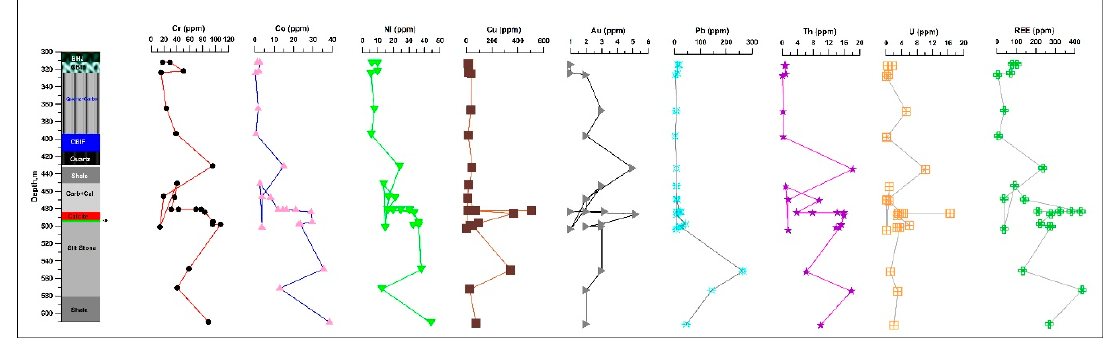
Minerals 2020 , 10 , x FOR PEER REVIEW Figure 11. Lithology of DDH-1 drill core with vs assay data. Figure 11. Lithology of DDH-1 drill core with vs assay data.